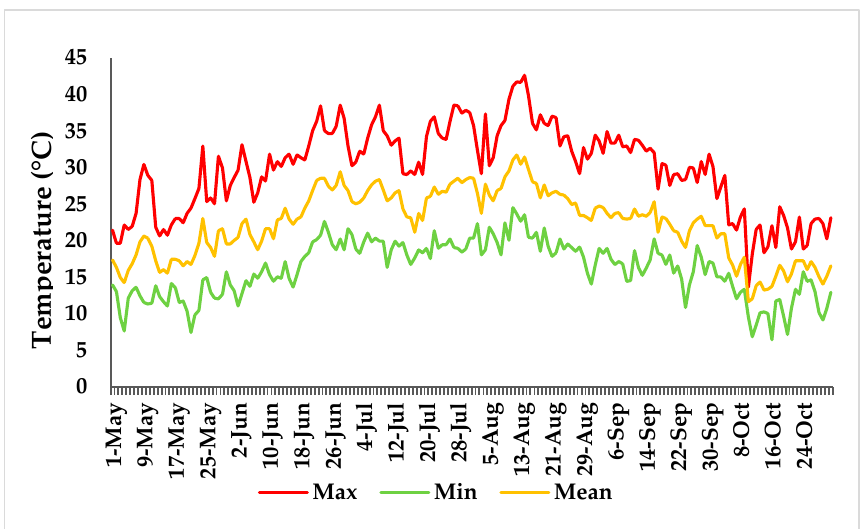
Figure 1. Temperature variation: maximum, minimum, and mean temperature (°C) recorded during the growing season in the open field (from May to October in “Castelvenere”—BN).